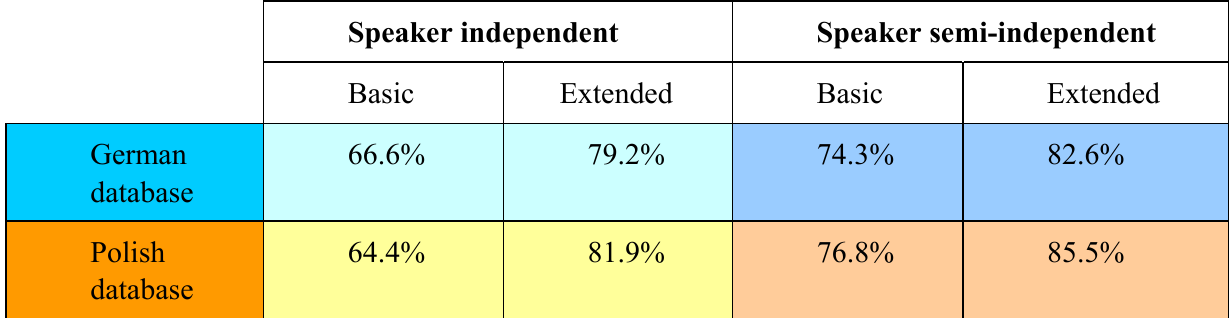
Table 4. Emotion sensing rates for two different initial pools of features: without the proposed variability descriptors (Basic) and with the descriptors (Extended), for four-element feature